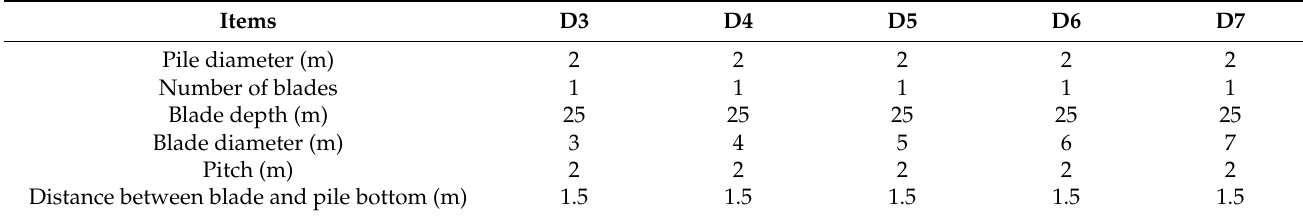
Table 4. Helical pile parameters for various spiral blade Figure 20. V/S ratio of helical pile with different pitches at displacement of 0.1 m.